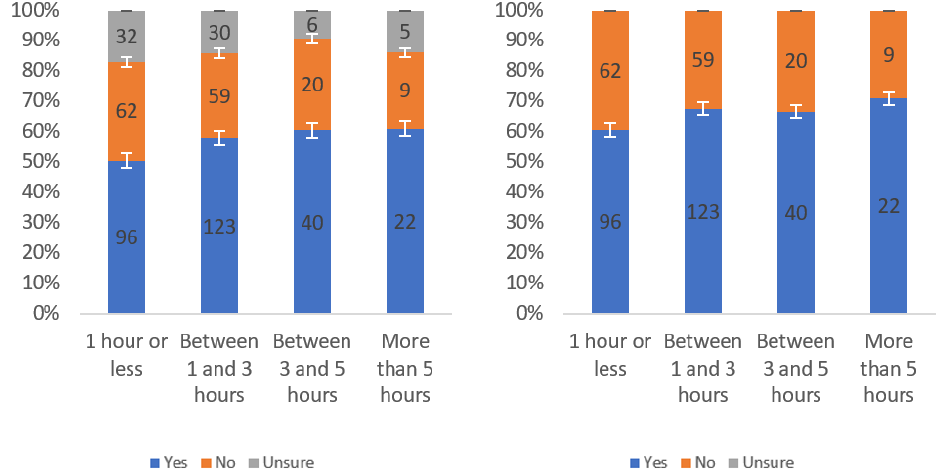
Figure A24. Responses regarding respondents’ willingness to review by internet usage level including ( left ) and excluding ( right ) unsure responses.